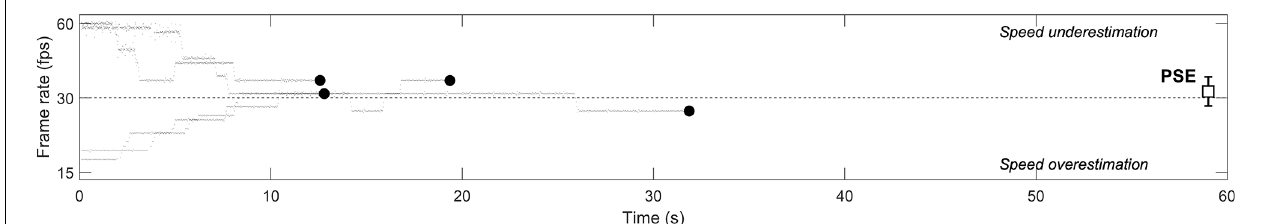
FIGURE 1 | Example of single-trial adjustment traces over time in an individual participant (female, 26 year-old), as assessed through the instantaneous video frame rate (the traces are noisy because it is shown the time stamp of the video frame flipping on the graphics hardware, which is not under full experimental control; however, temporal smoothing in the visual system masks these microscopic frame rate irregularities). Each filled circle marks the video speed at the time of the keypress (actually the median frame rate during the previous 500 ms, to prevent undesired effects of noise), which confirmed the participant’s speed choice and passed to the next trial. Also illustrated is the point of subjective equivalence (PSE, rightward open square, computed as the mean of the final video speed of each trial, which in this case was slightly higher than the original video speed, indicating speed underestimation) together with the standard deviation (error bar, from which the coefficient of variation is computed, see text). The horizontal dashed line indicates the original video clip speed (30